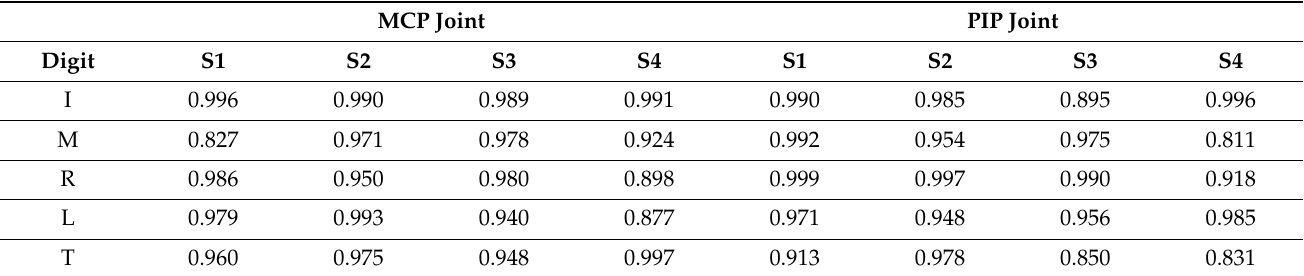
Table 4. Pearson’s correlation showing comparison of goniometric values versus angles generated linearly from data